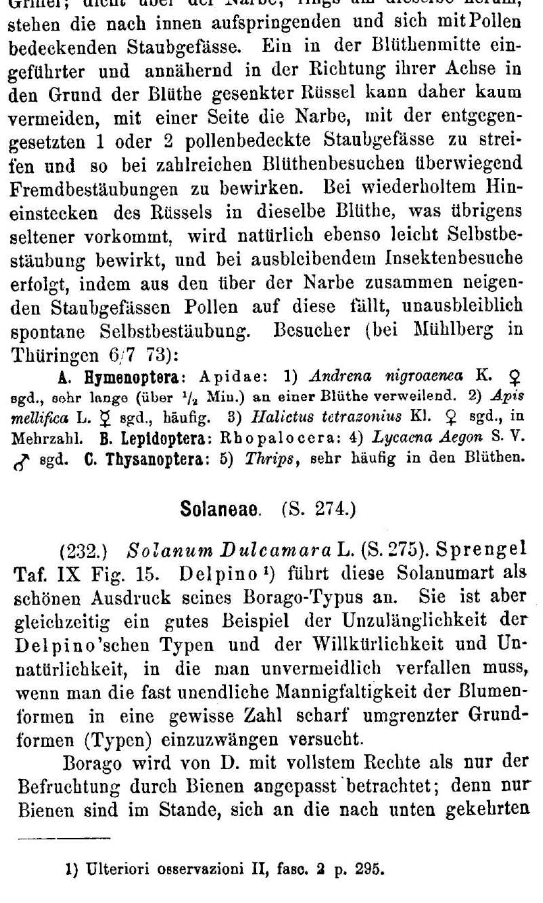
Fig. 2. The page from Müller (1882) that begins the discussion of pollination of Solanaceae, in particular of Solanum dulcamara